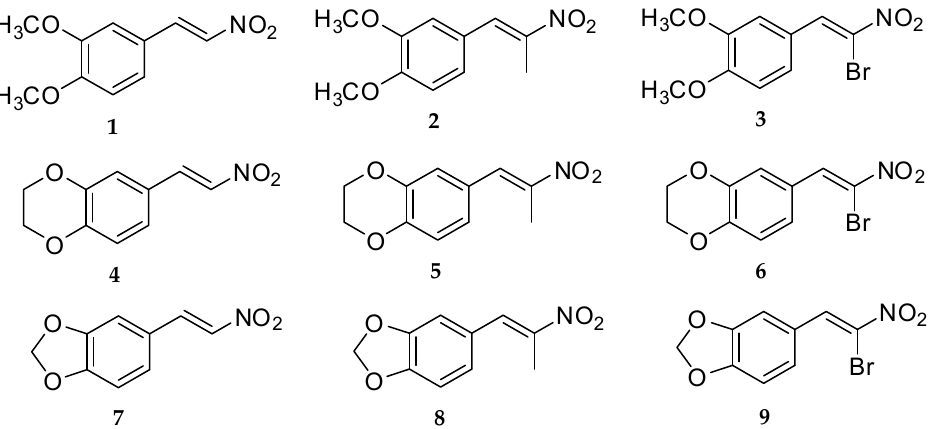
Figure 2. 3,4-Dimethoxy- β -nitrostyrene derivatives synthesized in the study. The number (1–9) was used to represent the name of the compounds .